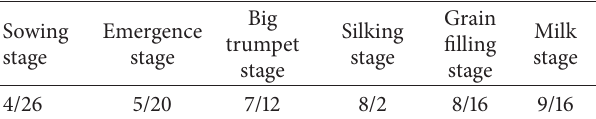
Table 1: Dates of growth stages of maize on saline-alkaline soil